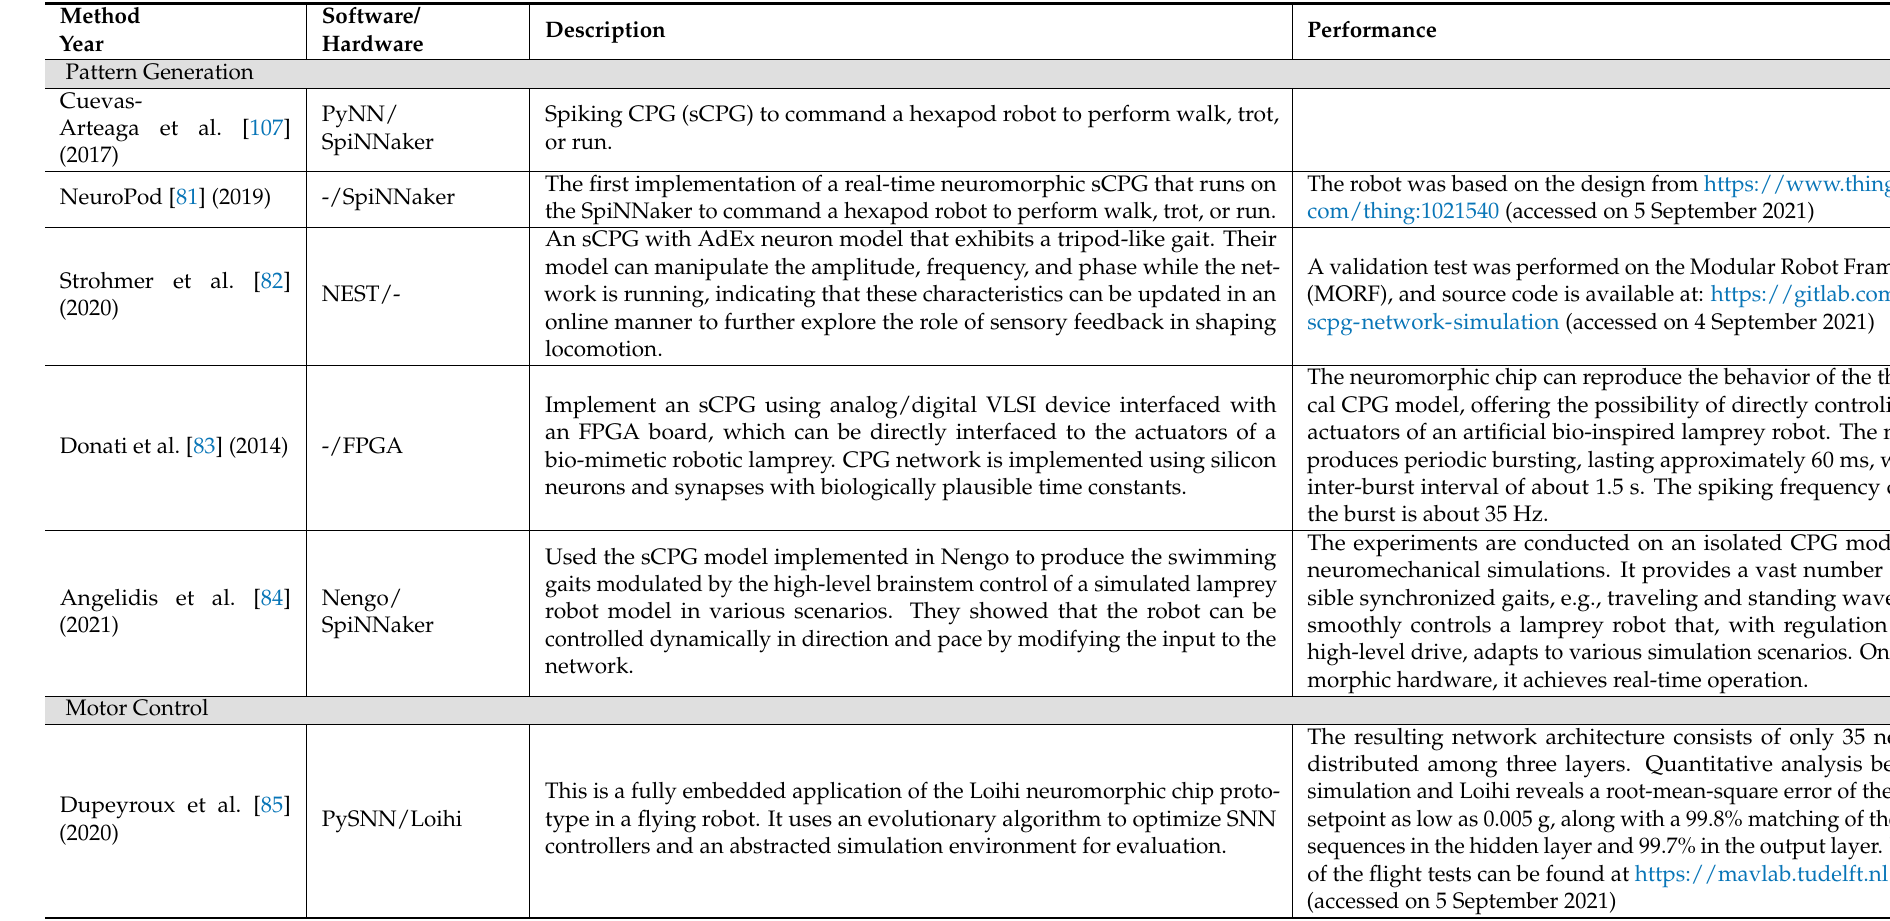
Table 3. Summary of recent applications of SNNs in